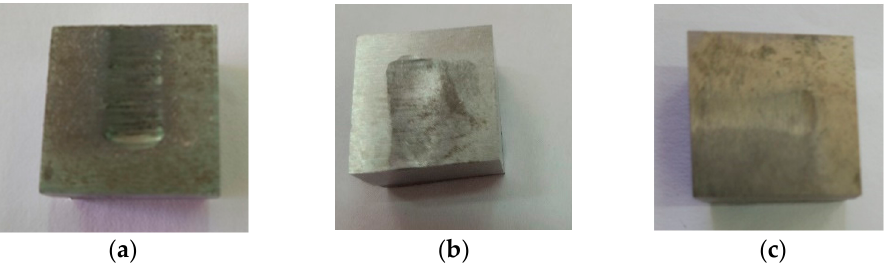
Figure 11. The cross-sectional views of the sample working surfaces at the end of the second set of